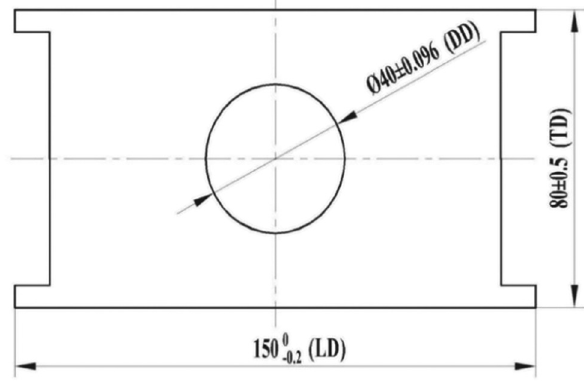
Figure 1: Dimension and tolerance requirements of the plate ( unit: mm )